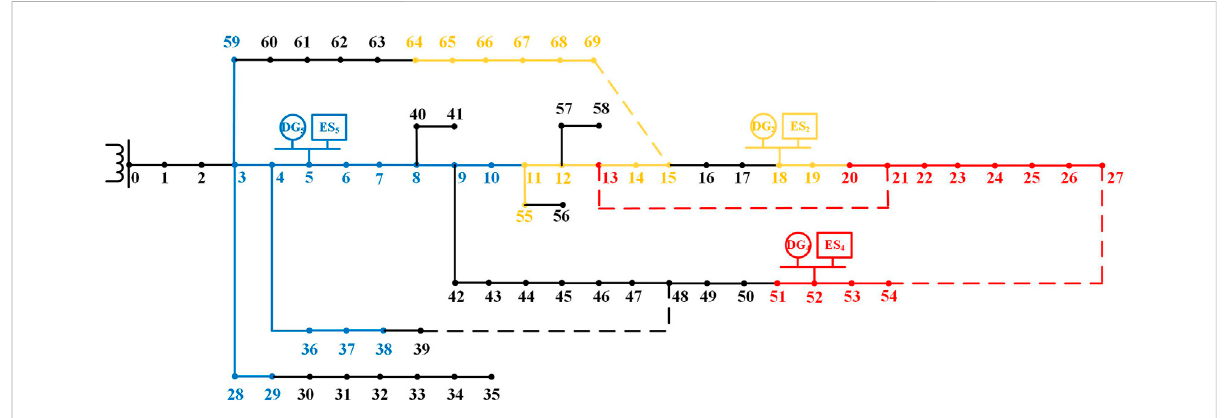
FIGURE 4 The island partition scheme based on the MIP model.